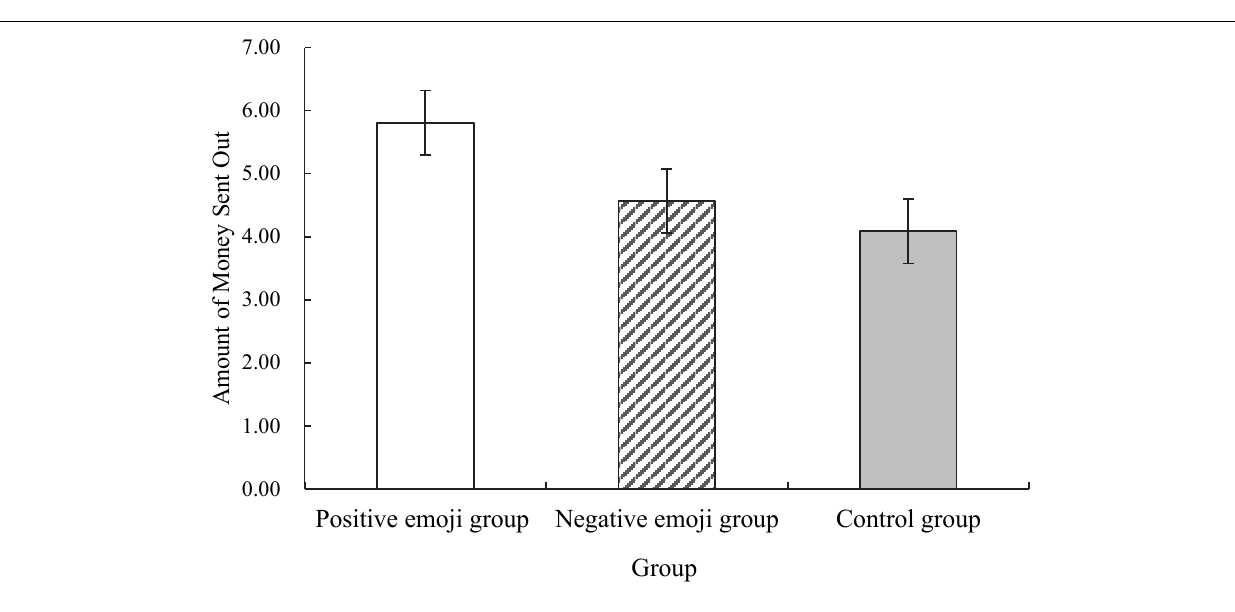
FIGURE 4 | Differences between the amounts of money sent out by the control group and the positive and negative emoji